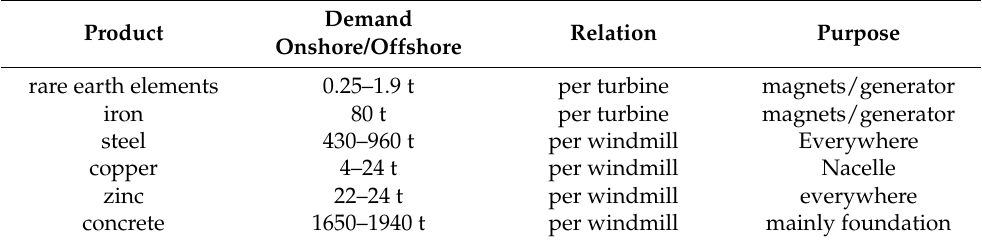
Table 2. Commodities demand of windmills based on [42,54] using a direct drive with permanent magnet generator (DD-PMSG) turbine as offshore and a gearbox permanent magnet generator (GB-PMSG) turbine as large onshore representative incl. cables and connection.